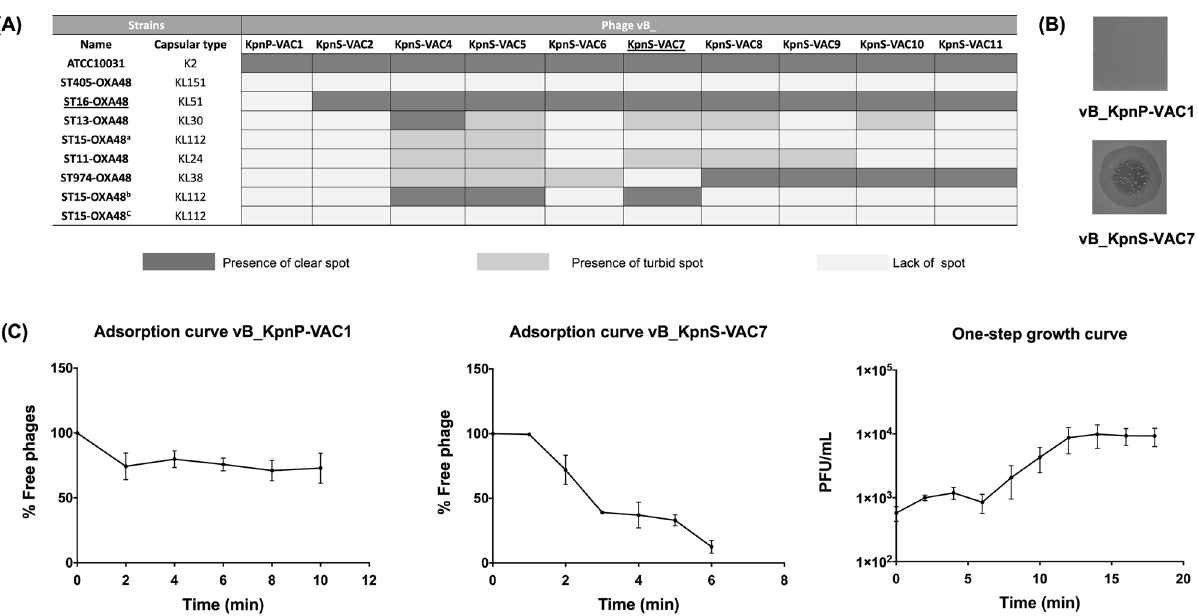
Figure 2. (A) The strain infectivity assay was performed with the ten lytic phages and the collection of clinical strains of K. pneumoniae , in which all strains harboured the lncL-type plasmid carrying the OXA-48 carbapenemase and the PemK/PemI TA system. The reference strain ATCC10031 was used as a control. Light grey indicates lack of spot; dark grey indicates presence of clear spot; grey indicates presence of turbid spot. (B) Spot test of phages vB_KpnP-VAC1 and vB_KpnS-VAC7 in the clinical strain ST16-OXA48. (C) Adsorption curve for phages vB_KpnP-VAC1 and vB_KpnS-VAC7, and the one-step growth curve of phage vB_KpnS-VAC7 at an MOI of 0.001 in the clinical strain ST16-OXA48. L latent time; B